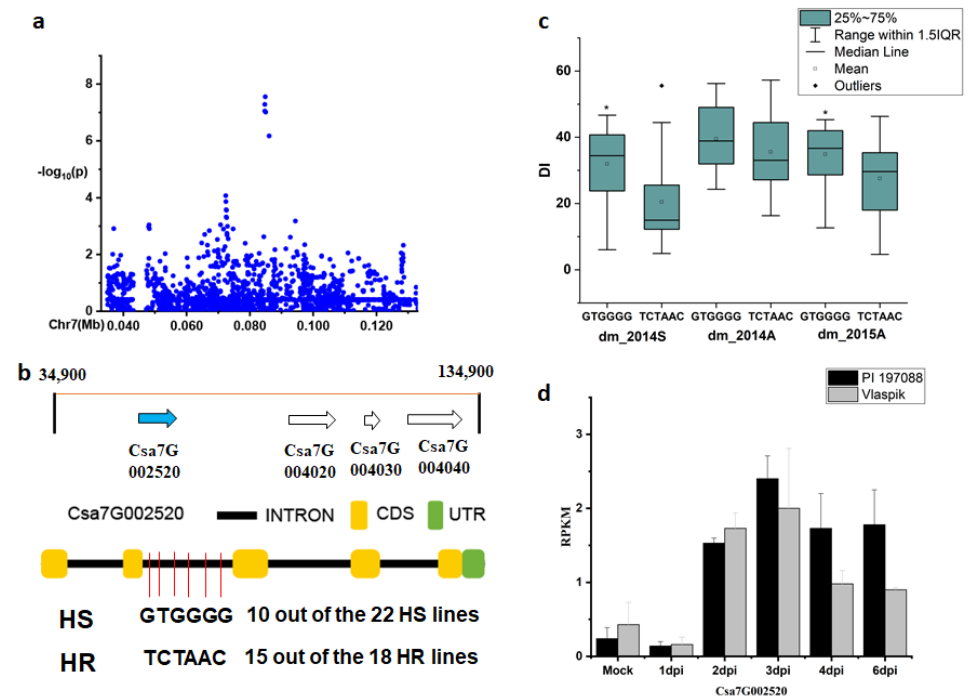
Figure 6. Identification of the causal gene for the locus dmG7.1 . ( a ) Local Manhattan plot surrounding the peak of dmG7.1 ; ( b ) four genes predicted in the 50-kb region around the peak dmG2.1 and SNP variation of the candidate gene Csa7G002520 between the highly susceptible (HS) and highly resistant (HR) lines (see Supplementary File 5); ( c ) disease index (DI) comparison between haplotypes of the HS and HR lines (see Supplementary File 3); ( d ) RPKM of candidate gene Csa7G002520 based on the transcriptome of PRJNA285071 (data obtained from http://cucurbitgenomics.org/rnaseq/cu/19)[24]. * indicates significance at p < 0.05.